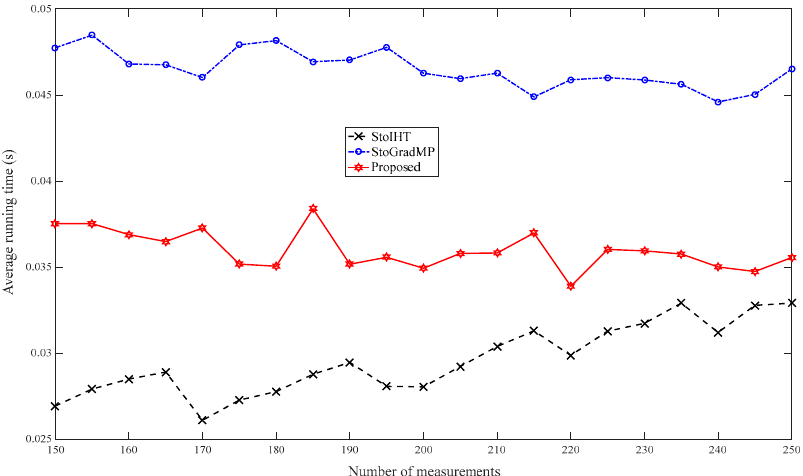
Figure 7. Average running times of the di ff erent algorithms ( n = 256, K = 24, κ = 0.6, m = 150 : 5 : 250, Gaussian